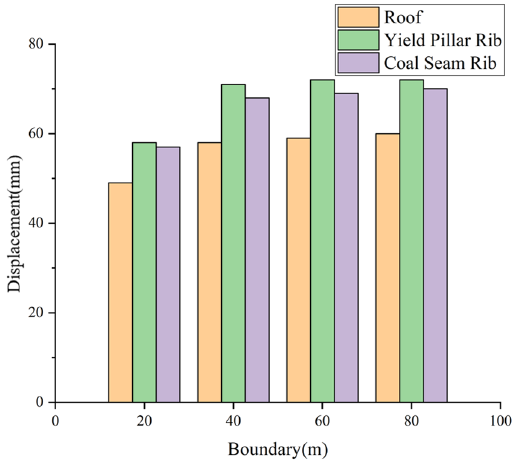
Processes 2022 , 9 , x FOR PEER REVIEW Figure 5. The influence of boundary effects on the model. Figure 5. The influence of boundary effects on the model.